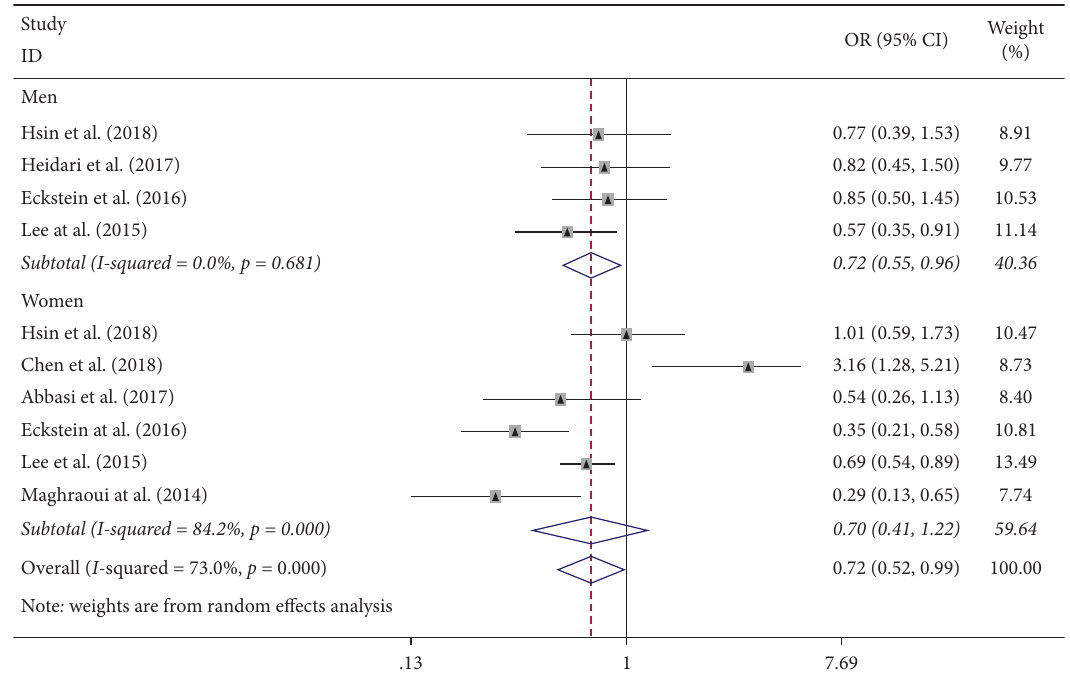
Figure 2: Forest plot showing the association between MS and the risk of osteoporosis (osteoporosis vs.